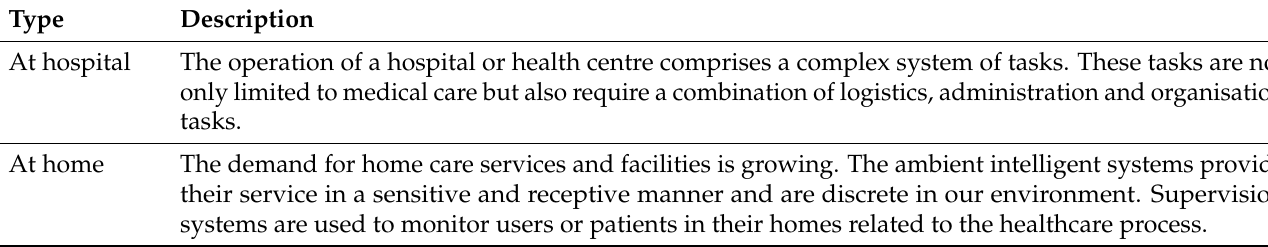
Table 4. Classification of assistance robots according to the application